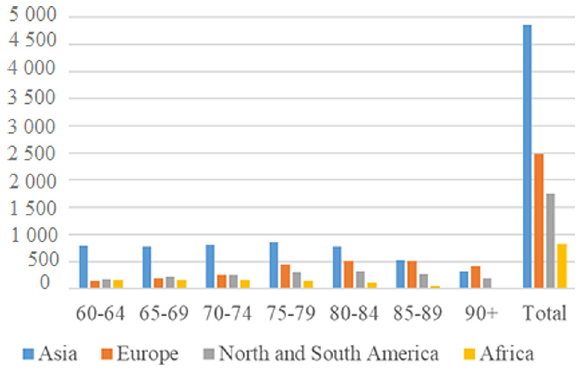
Fig. 1. The annual number of people with dementia by age group and macroregions of the world, in thousands, 2015. Source: based on World Alzheimer’s Report How to live suffering from dementia and the person who is close to him (Kak zhit’ stradayushchemu de-